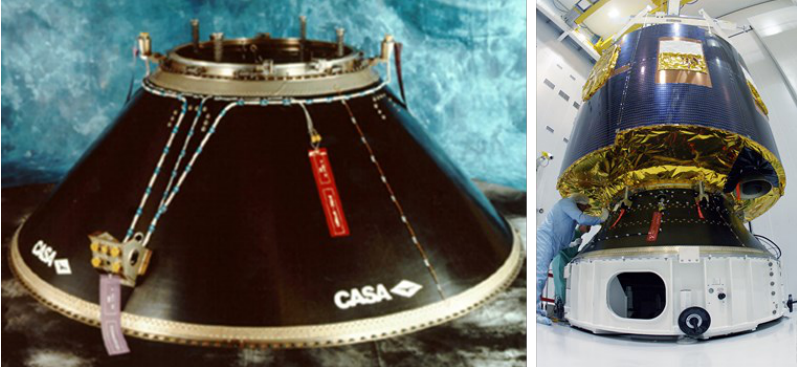
Figure 13. Schematic diagram of PAF [38,39].